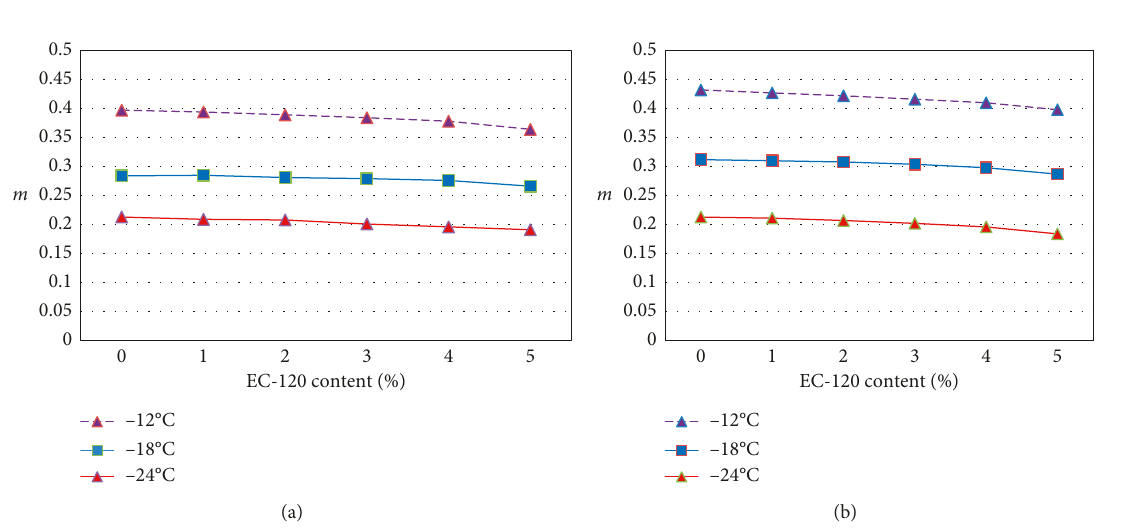
Figure 2: Relationships between S of WMA binders and EC-120 content. (a) Warm-mixed matrix asphalt A-70. (b) Warm-mixed SBS I-D.